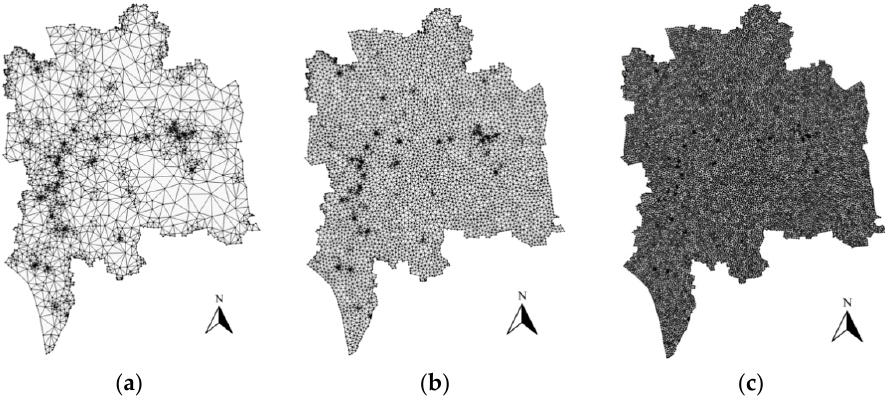
Figure 4. Schematic of different degrees of division. ( a ) First division; ( b ) second division; ( c ) third